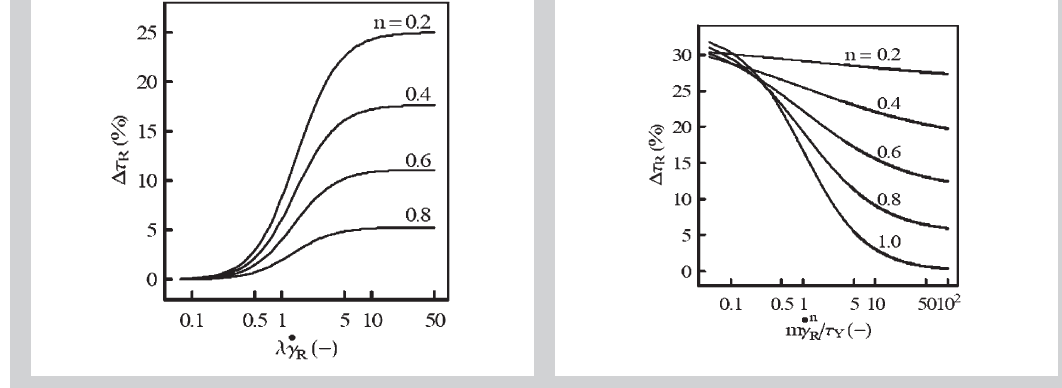
with Variation of Dt R dimensionless rim shear rate m g · Rn / t for Herschel- Y Bulkley model with power- law index n as an indepen- dent